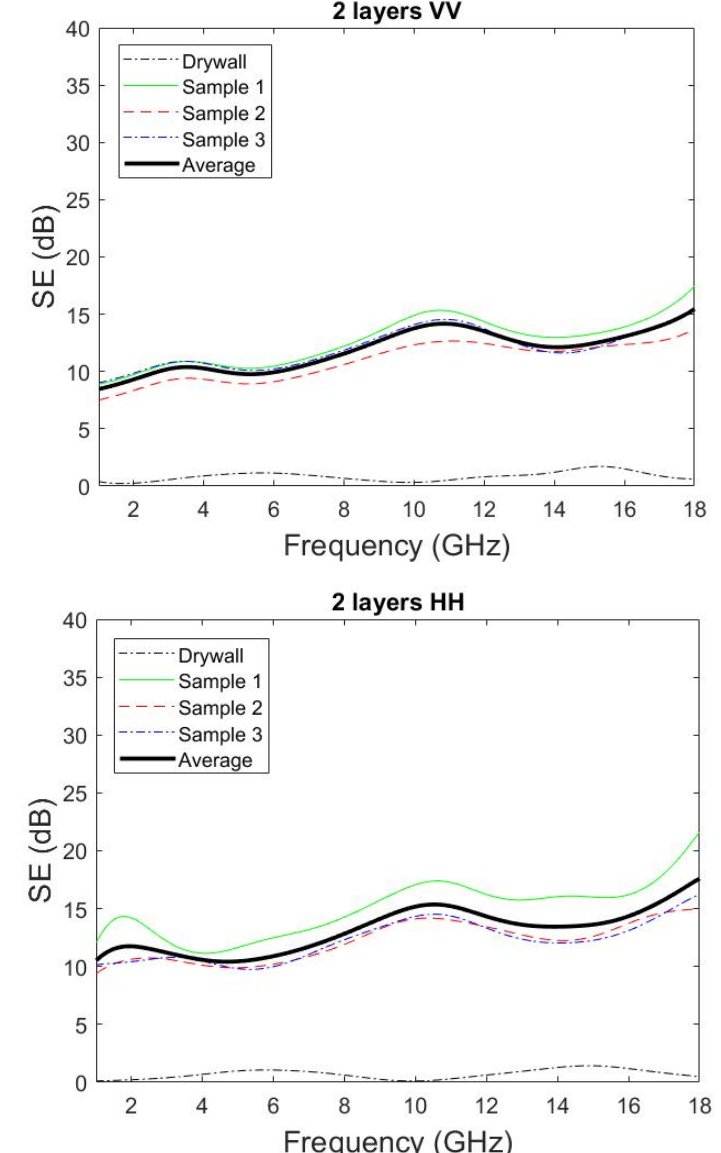
Figure 6. Plots of the SE versus frequency for 2 ‐ layer samples. Vertical polarization ( top panel ); horizontal polarization ( bottom panel ).